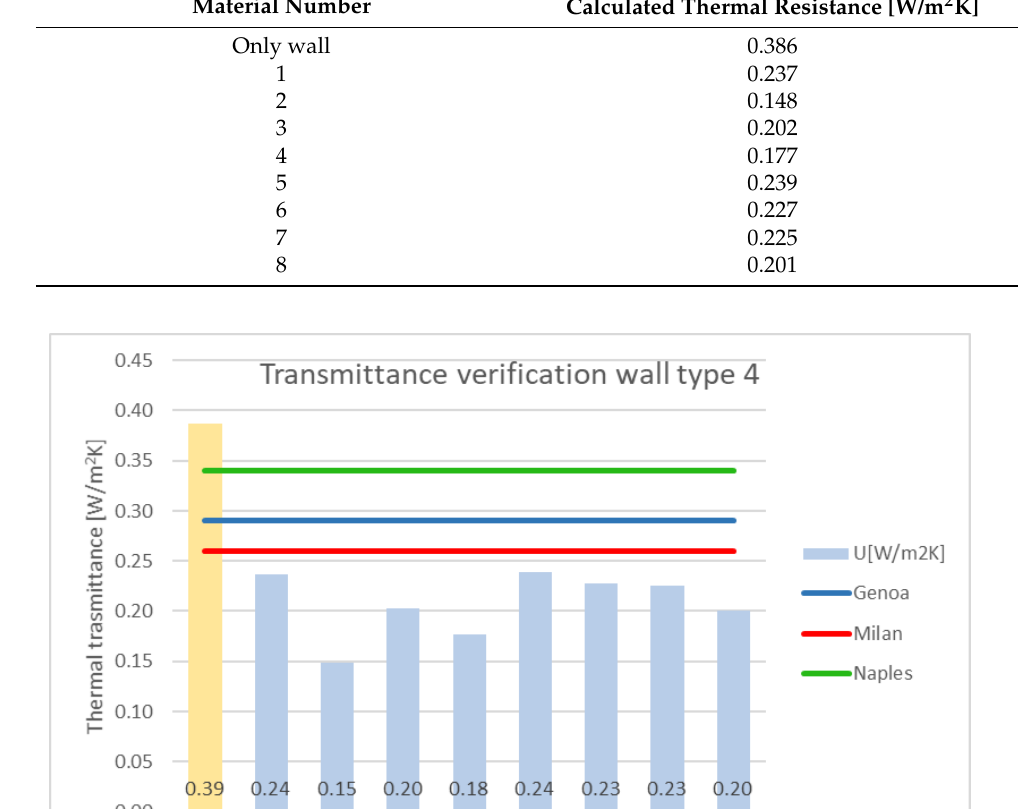
Figure A13. Wall type 5.1: stratigraphy with thicknesses and conductivities for the different layers. The numbers start from the outside.